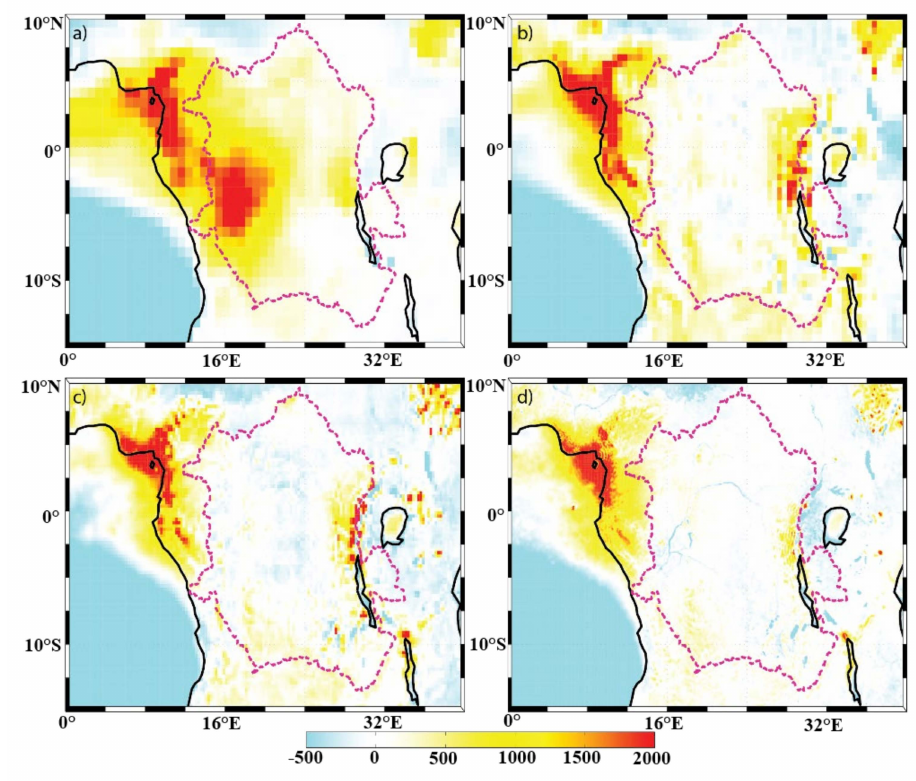
Figure 6. Spatial distribution of annual mean P-E (mm/y) of the ( a ) ERA-I; ( b ) eERA5; ( c ) ERA5; and ( d ) ECOA datasets from 2016–2017. The Congo Basin is outlined with a dotted